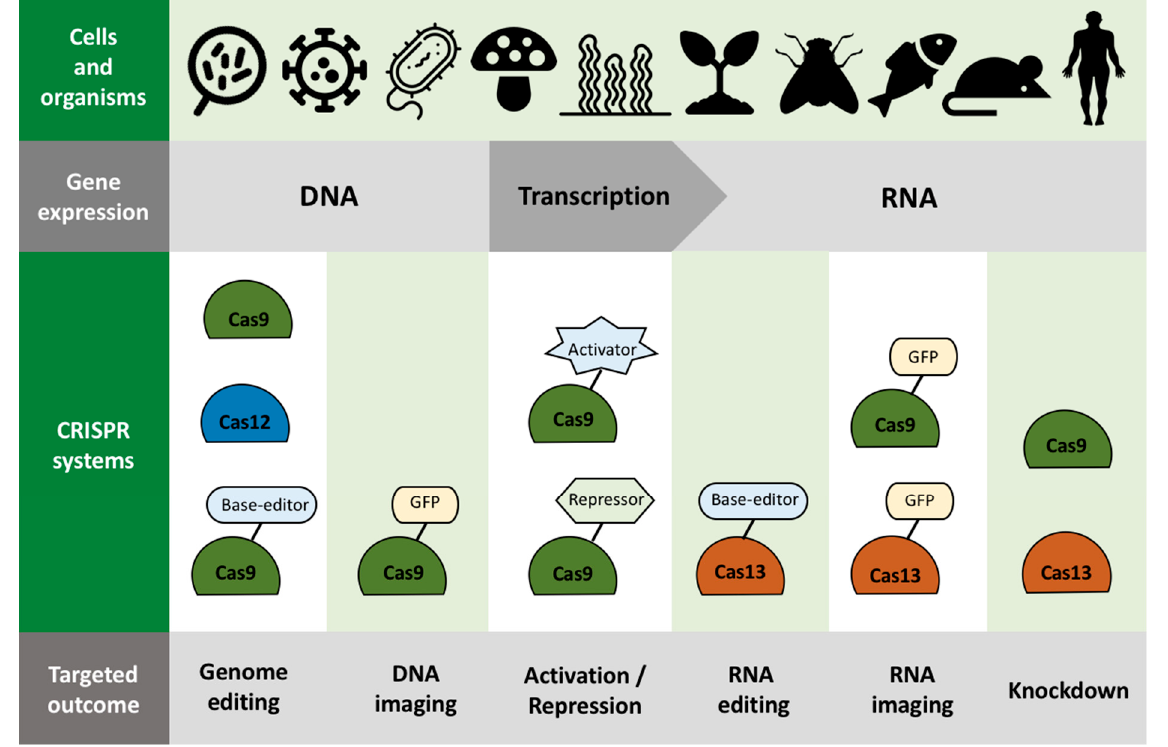
Figure 2. Common CRISPR/Cas systems used for genetic manipulation.